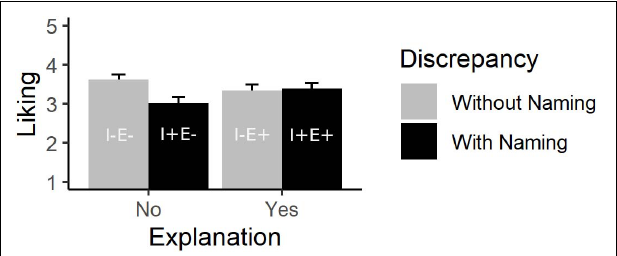
FIGURE 1 | Interaction between discrepancy and explanation with regard to liking. The error bars indicate standard